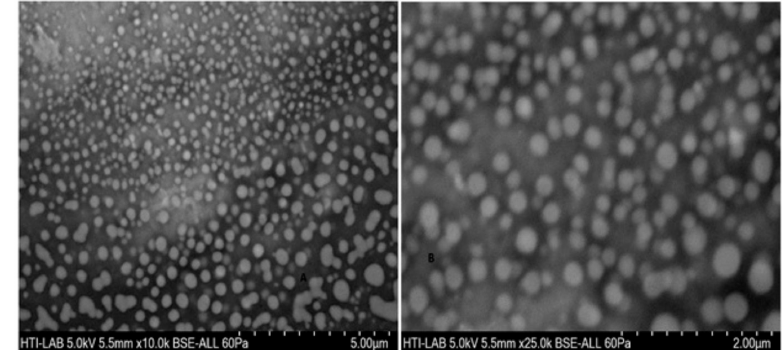
Figure 6. Field emission scanning electron microscope (FESEM) images of ( A ) placebo chitosan nanoparticles and ( B ) rotigotine-loaded chitosan nanoparticles loaded CS